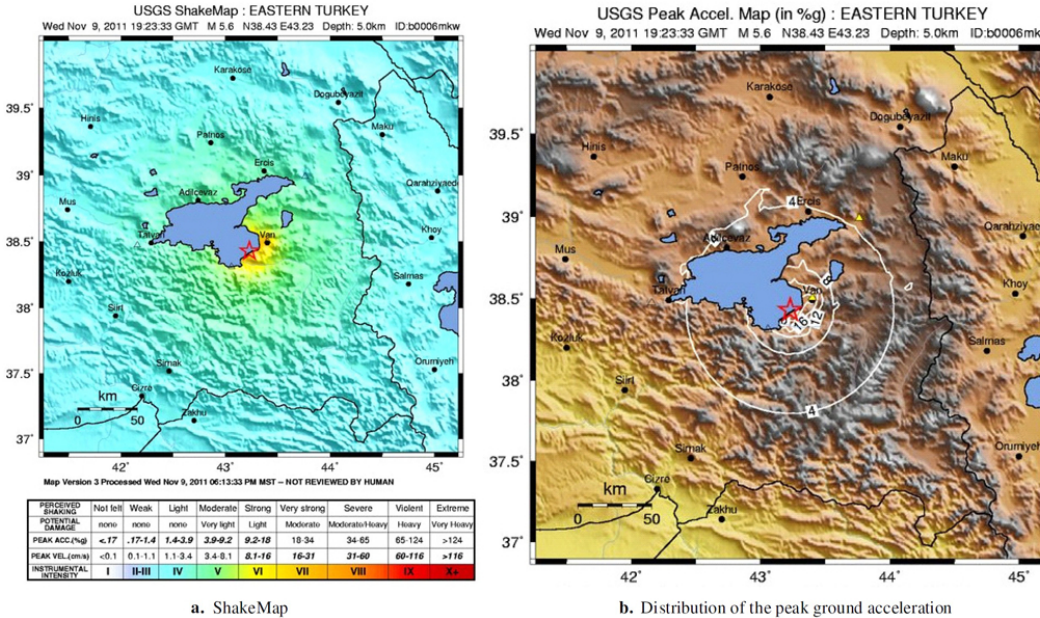
Fig. 4. The ground motion maps of the 9 November 2011 Van earthquake (USGS,